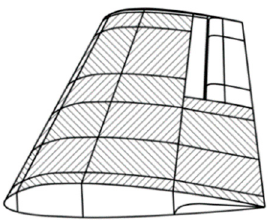
Figure 3. Contingent sections of the aircraft wing between ribs and